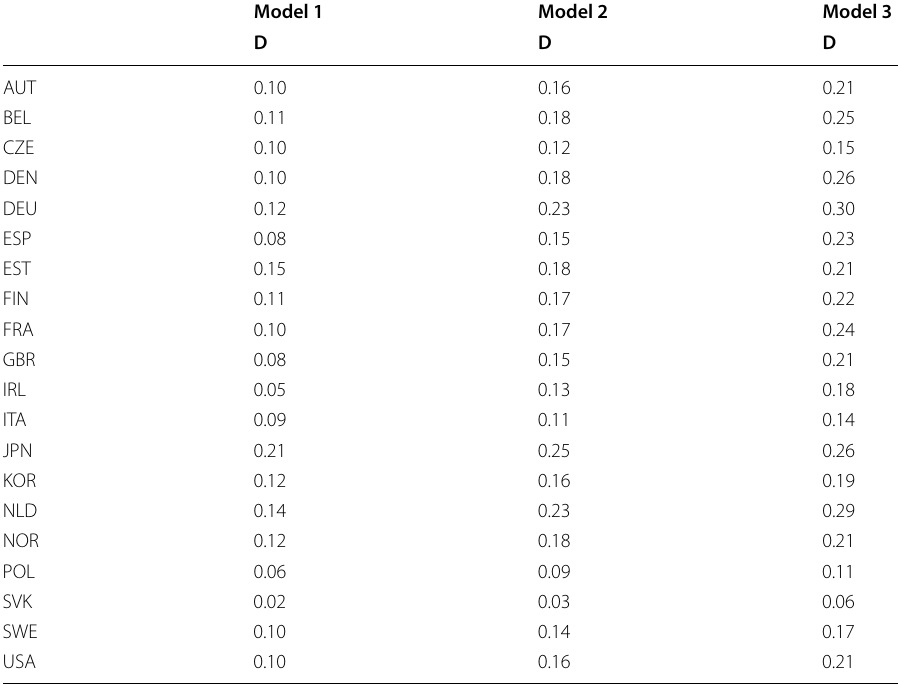
Model 1 Gender, age, ParEd, # of books at home = Model 2 Model 1 Cognitive Skill (standardized Literacy and Numeracy = +